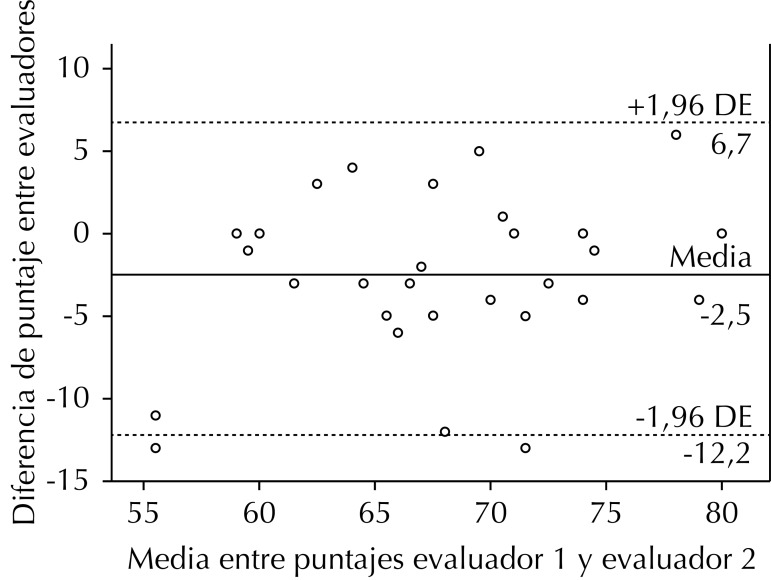
Bland-Altman inter-evaluador. Comparación de los puntajes de TGMD-2-CH obtenidos por dos evaluadores independientes. Santiago de Chile, 2013. (N = 32)